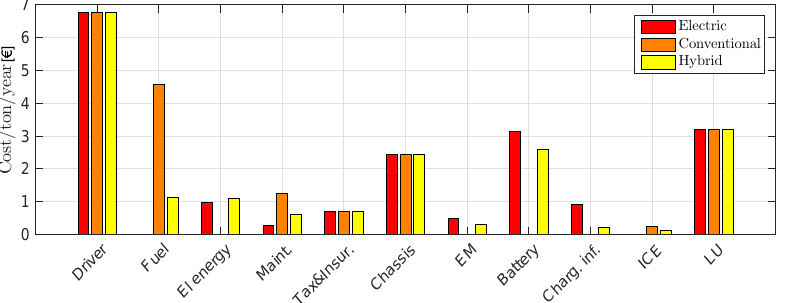
Figure 14. Sensitivity of annual costs per unit freight [ton] to optimum conventional, fully electric, and hybrid vehicles separated for different cost indicators on the first